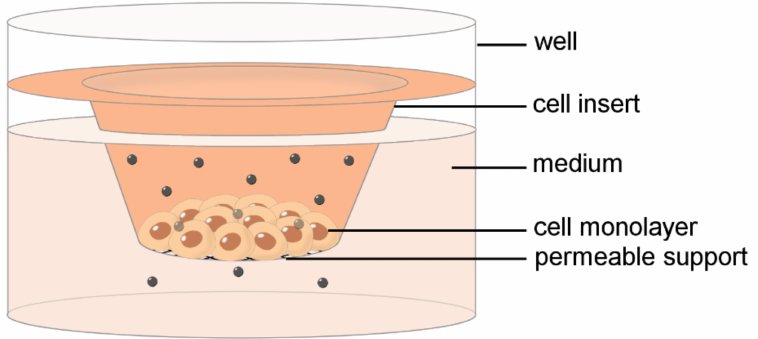
Figure 1. Schematic drawing of an in vitro 2D barrier model made of a culture well with a cell culture insert. Nanoparticles are administered in the medium in the cell insert and monitored for their passage to the lower chamber through the cell monolayer.